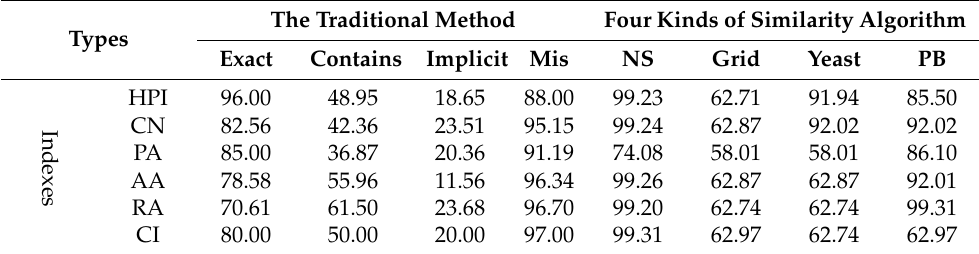
Table 7. The efficiency (%) of the traditional method and 4 kinds of similarity algorithms based on a complex network.